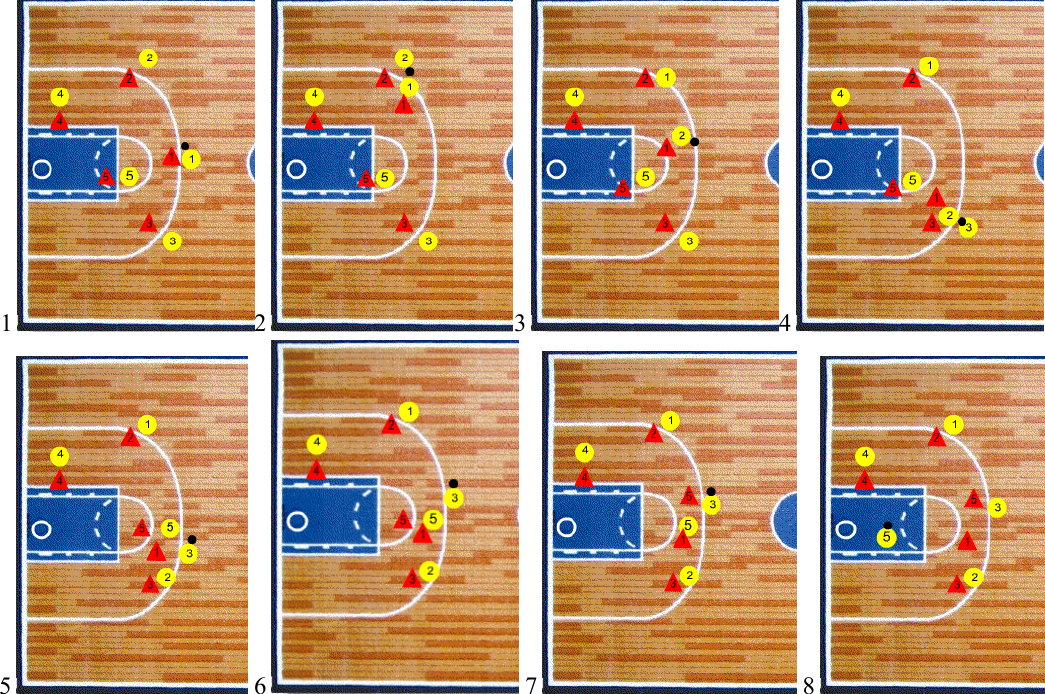
Fig.2. Shots of author’s video –aid with animation illustrations; illustration of tactic interaction “Little eight with center